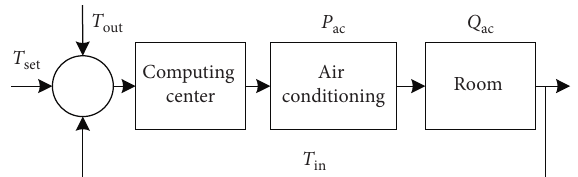
Figure 2: Schematic diagram of a closed-loop system in virtual energy storage with air conditioning